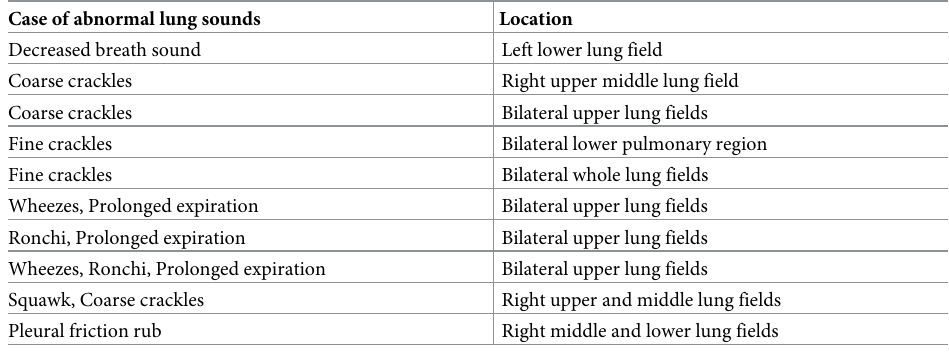
Table 1. Abnormal lung sounds and where they were listened, as used in the lung auscultation